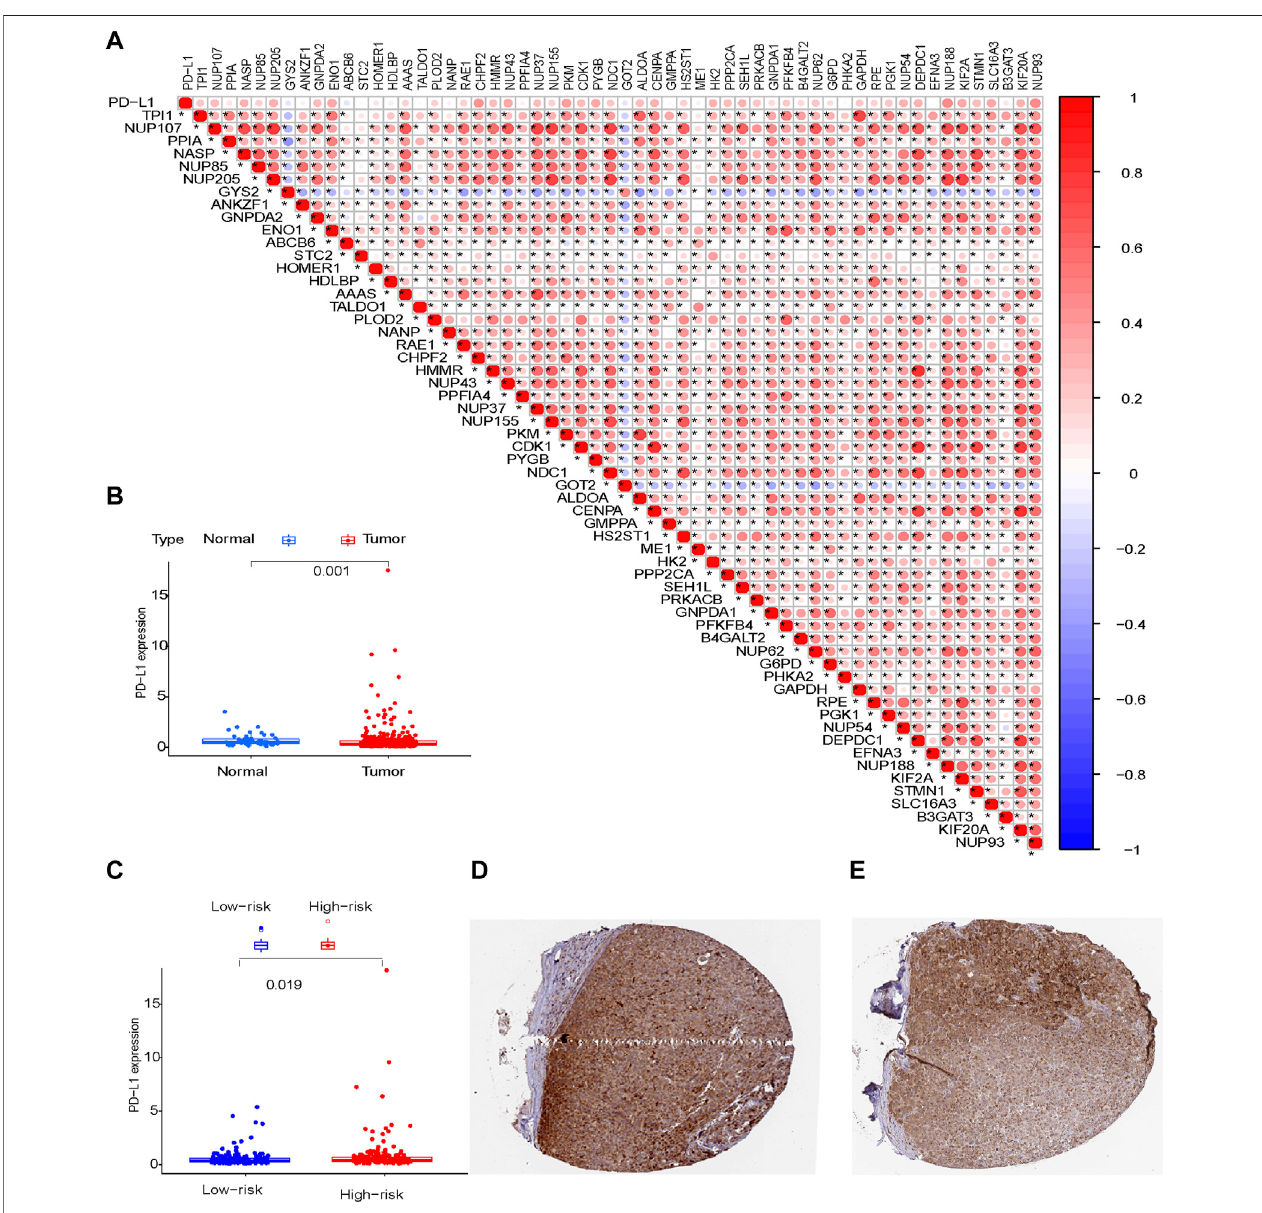
FIGURE 10 | PD-L1 protein expression (A) Risk model; (B) Normal tissue and tumor tissue; (C) Tumor tissues from patients in the low-risk and high-risk groups; (D,E) Tumor tissues derived from the HPA database.